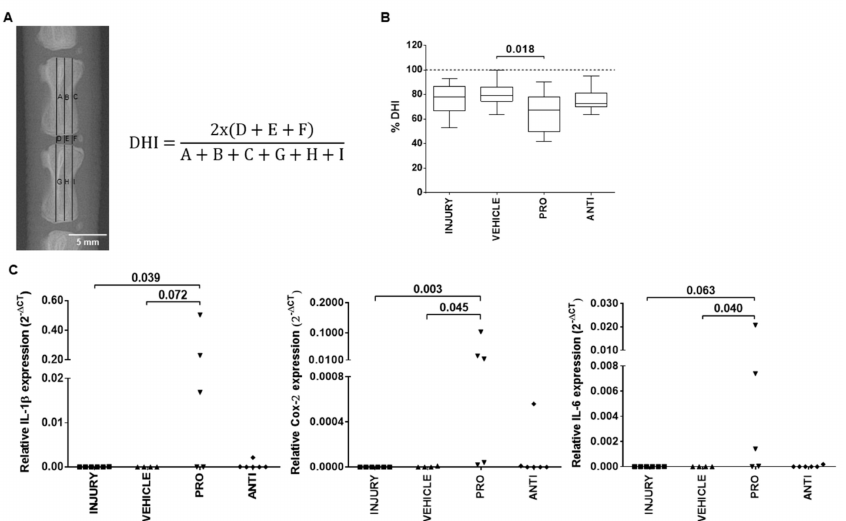
Figure 2. Local e ff ect of the di ff erent injectable treatments (VEHICLE; PRO-; and ANTI-inflammatory) in the radiological features and local inflammatory response of degenerated / herniated intervertebral disc (IVD), 2 weeks postinjury. ( A ) Representative digital radiograph and disc height index (DHI) calculation formula obtained as the mean of three measurements from midline to the boundary of the central 50% of disc width, divided by the mean of the two adjacent vertebral body heights. ( B ) Percentage of DHI (% DHI) calculated for each disc by the di ff erence in DHI between post- and preinjury. The % DHI preinjury corresponds to 100% (dashed line). Results are presented in box-and-whiskers plots with associated p -value ( n = 6 mice / group). ( C ) Relative gene expression of pro-inflammatory markers IL-1 β , COX-2 and IL-6 in lesioned IVDs, normalized to GAPDH. Results are presented in dotplots with associated p -value ( n = 4–6 animals /